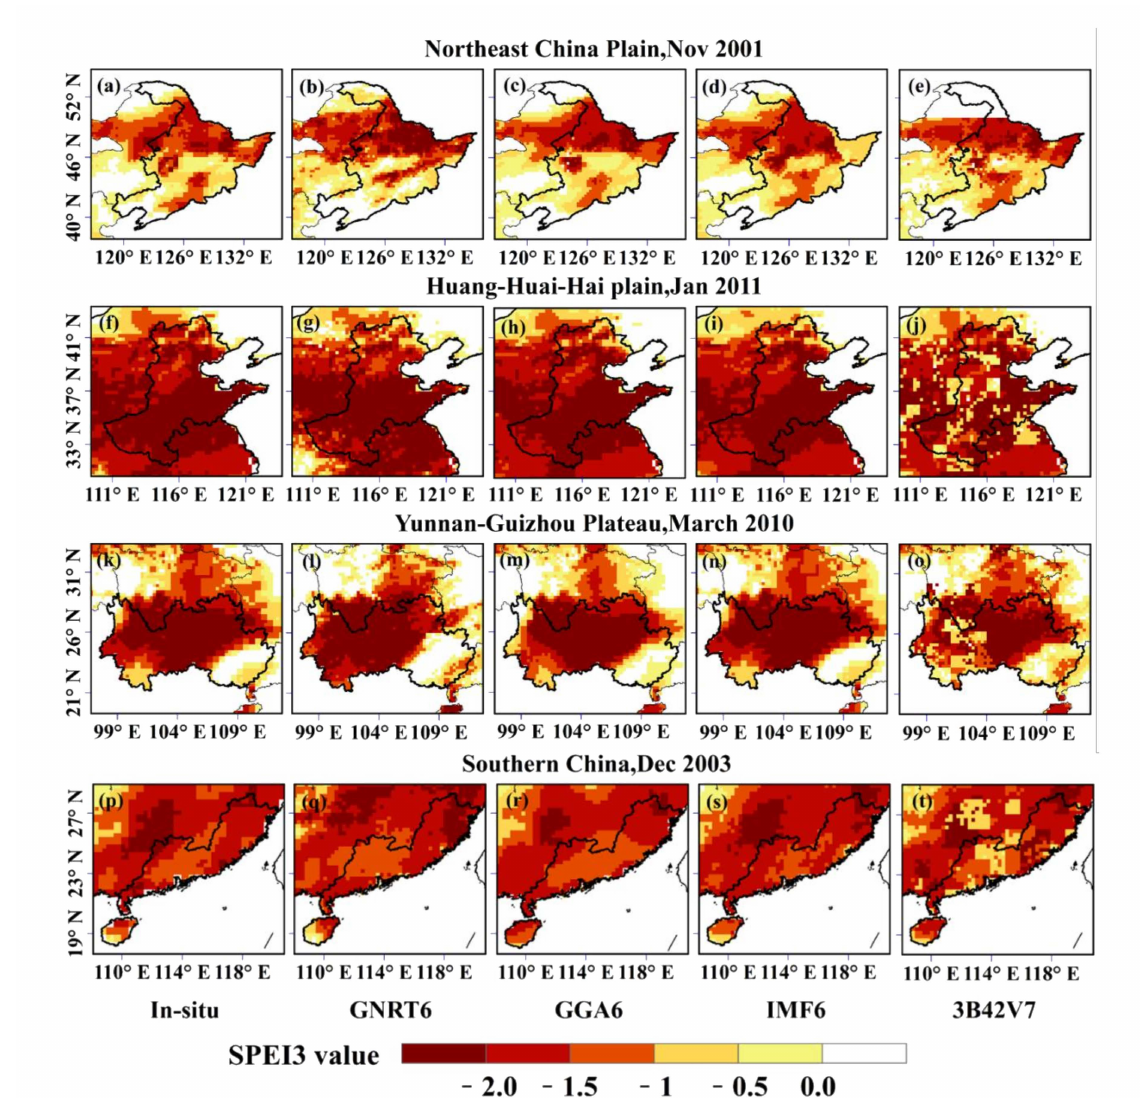
Figure 12. Spatial pattern of the typical drought events for the four typical drought-affected agricultural regions based on in situ observations ( a , f , k , p ), GNRT6 ( b , g , l , q ), GGA6 ( c , h , m , r ), IMF6( d , i , n , s ) and 3B42V7 ( e , j , o , t